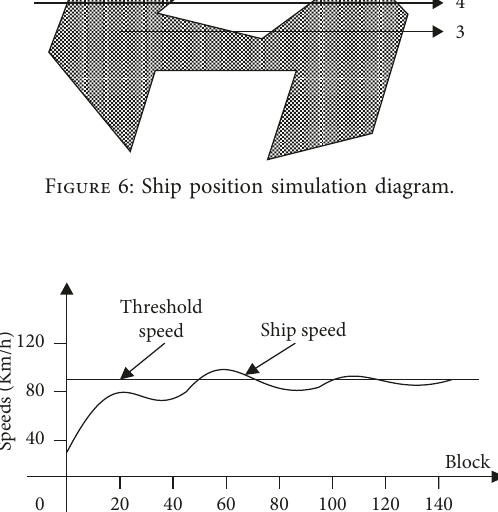
Figure 7: Graphic illustrating the dangerousness of a ship coming at high